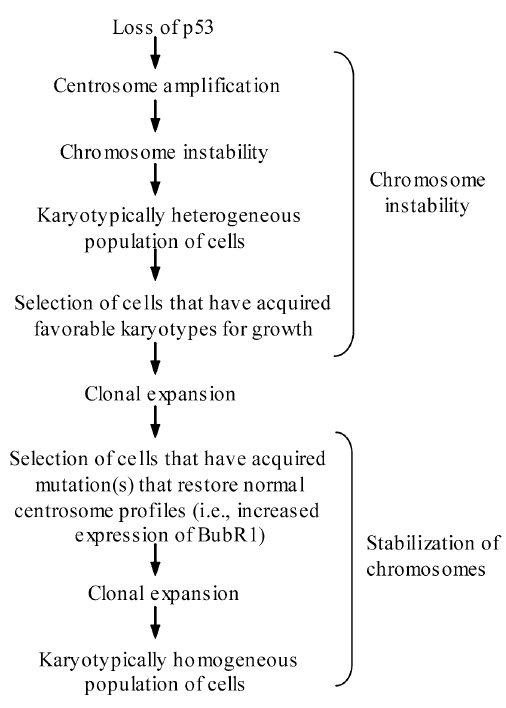
Fig. 3. Karyotypic convergence in cultured p53 − / −